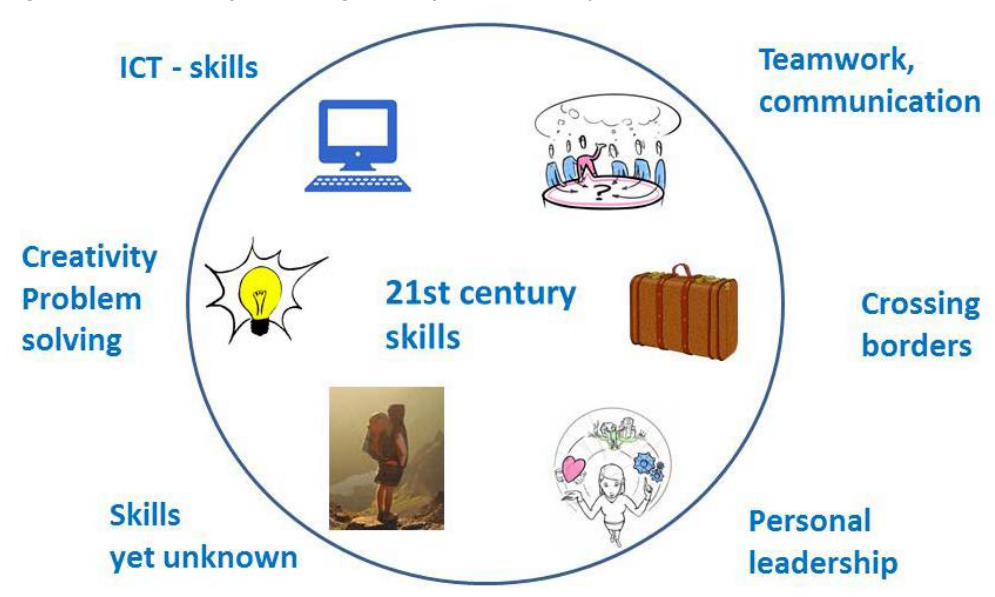
Figure 1: Scheme of six categories of 21st century skills